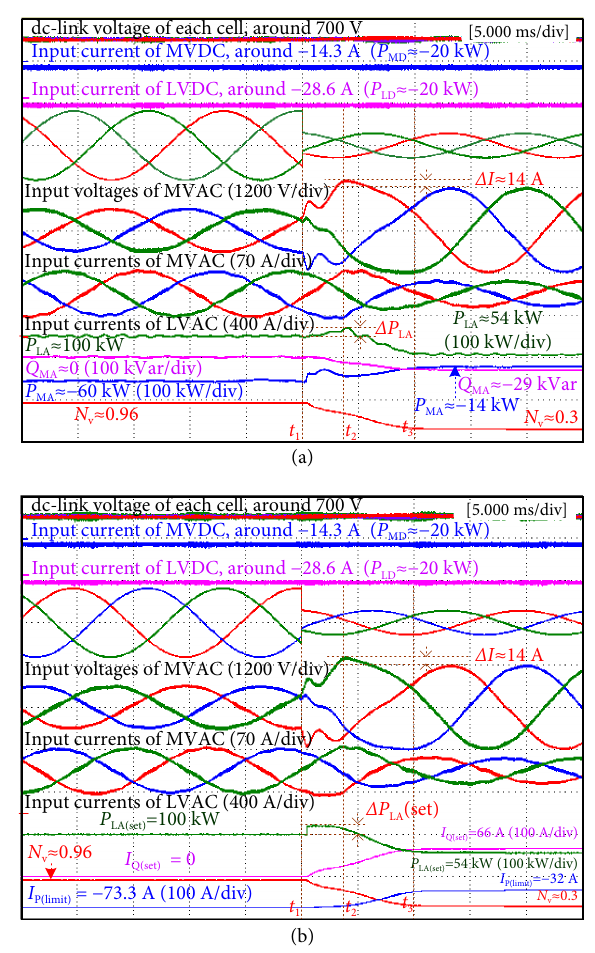
Fig. 25 Experimental results without optimized active-power regulation path. (a) Real-time power curve. (b) Power command